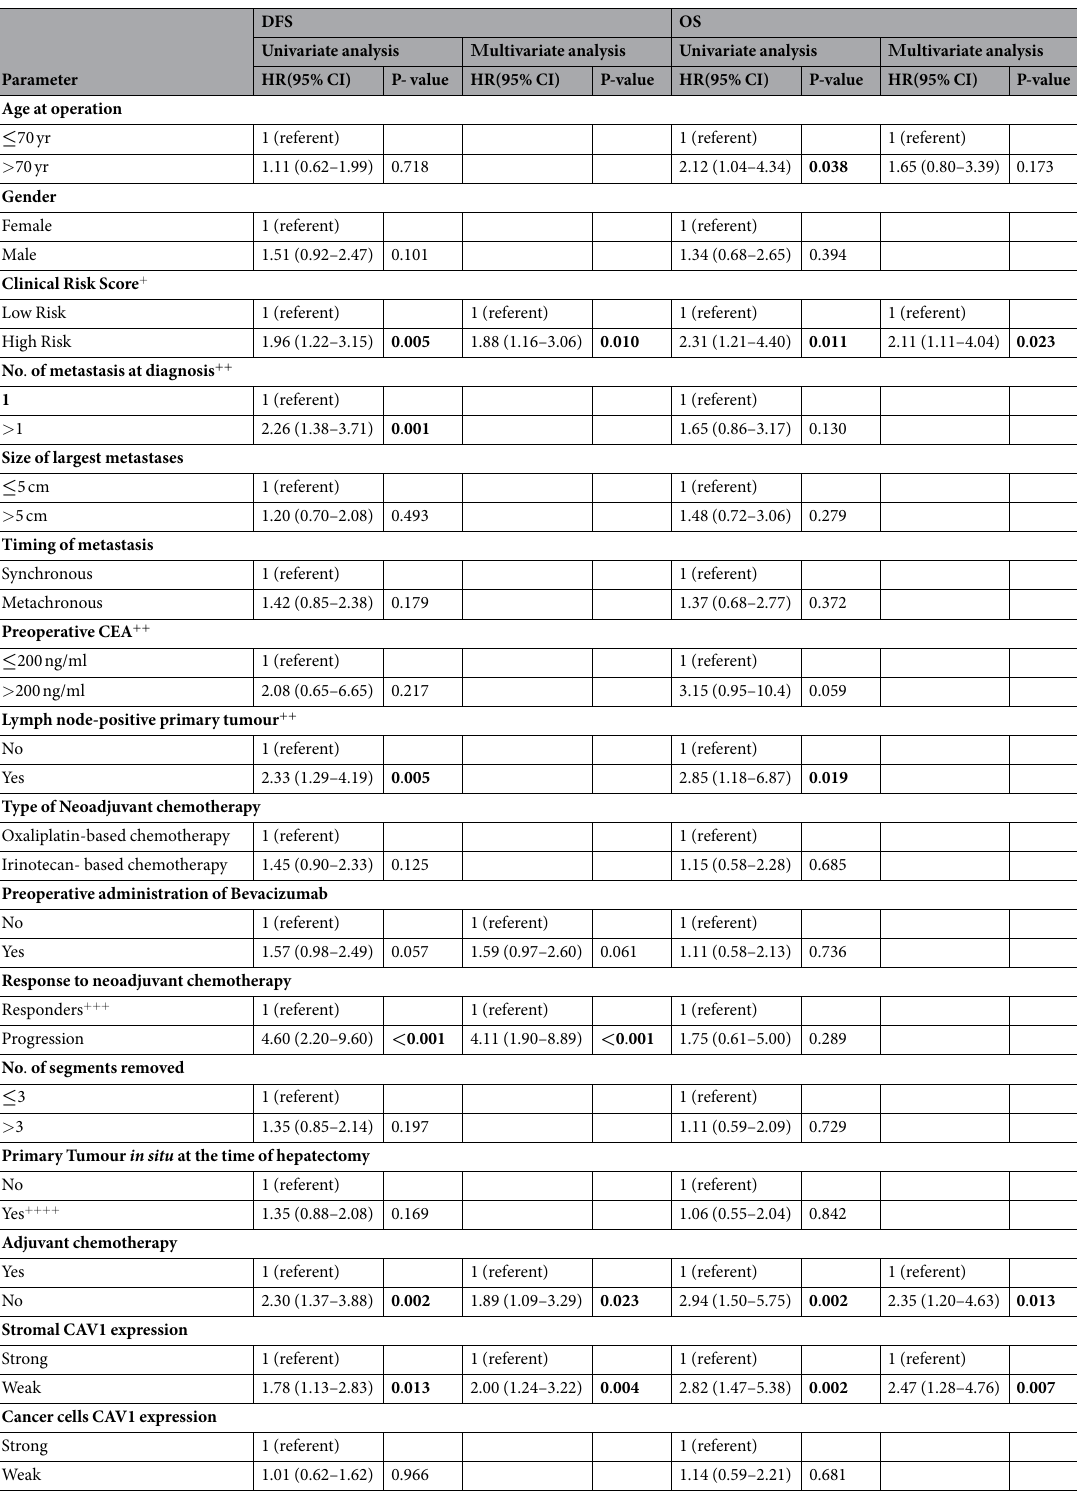
Table 2. Baseline clinicopathologic characteristics and their association with DFS and OS in univariate analysis and multivariate analysis. Abbreviation: DFS = disease free survival; OS = overall survival; HR = hazards ratio; CI = confidence interval; + Clinical Risk Score according to Fong Y et al . 5 . ++ Clinical Variables included in the Clinical Risk Score 5 . +++ Radiologic Complete Response or Radiologic Partial Response or Stable Disease (according to RECIST) 16 . ++++ 15 patients underwent synchronous resection of primary tumour and CRLM and 4 patient were management with ‘liver first’